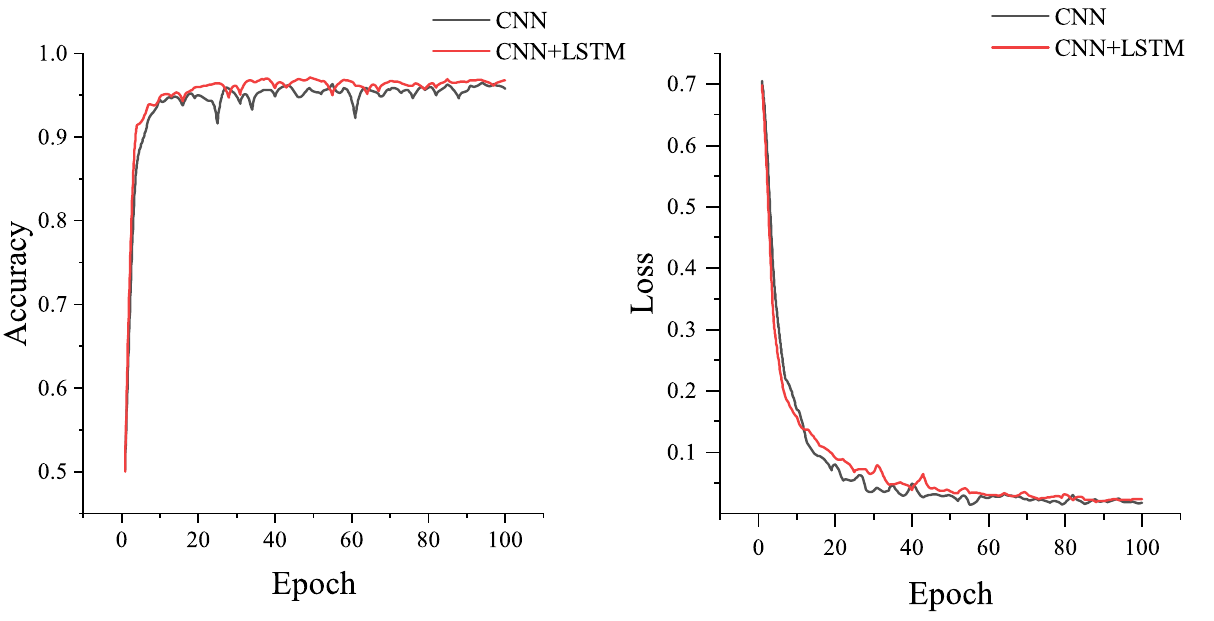
Figure 19. Training accuracy and loss curves of CNN and CNN-LSTM on small data size